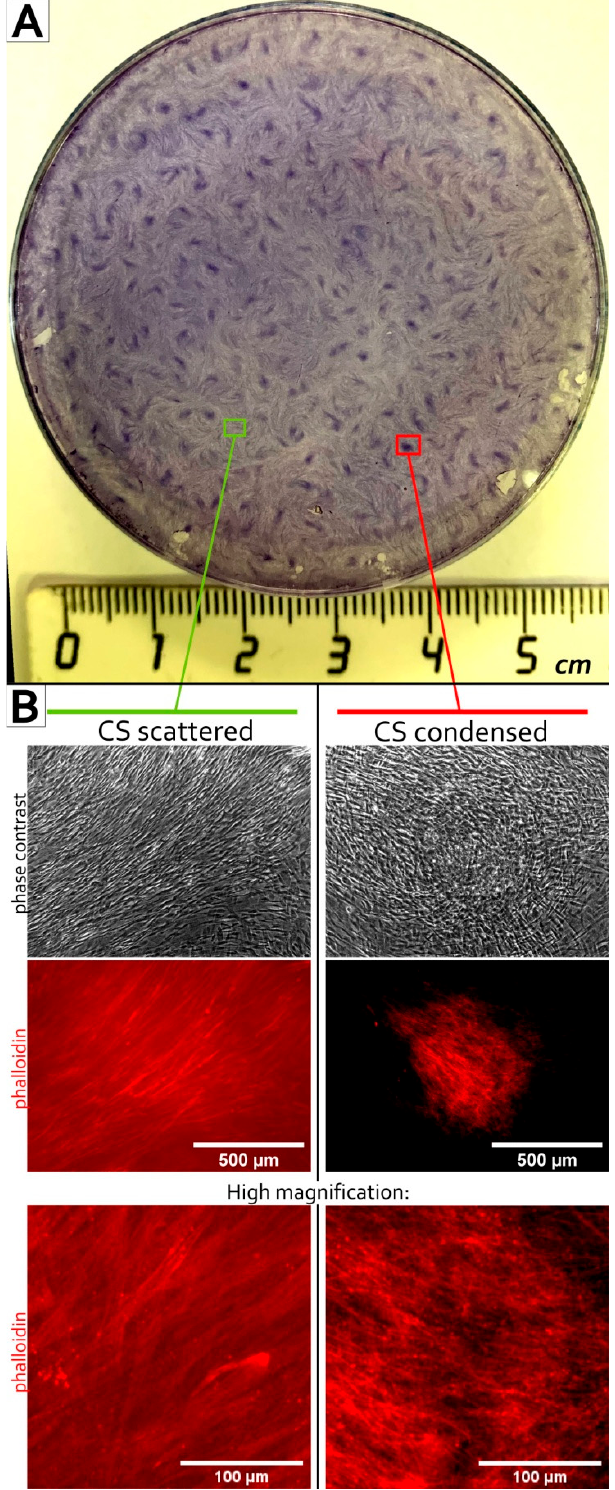
Figure 2. Cytoskeleton of the MSC within condensed areas of cell sheets (CS) is characterized by the high polymerization of F-actin to fibrillar structures. ( A ) Condensed areas are visualized as cell-rich regions with profound staining surrounded by scattered areas characterized by mild staining. CS were assembled from MSC cultured in a 60-mm Petri dish for 14 days; nuclei-stained by hematoxylin; scale bar—5 cm. ( B ). Condensed and scattered areas of CS demonstrate different patterns and the polymerization of the actin cytoskeleton. In condensed areas, sharply delineated F-actin fibers are visible (labeled by fluorophore-conjugated phalloidin), while, in scattered areas, a uniform background is visualized even at increased signal gains; fluorescent and phase-contrast microsco-